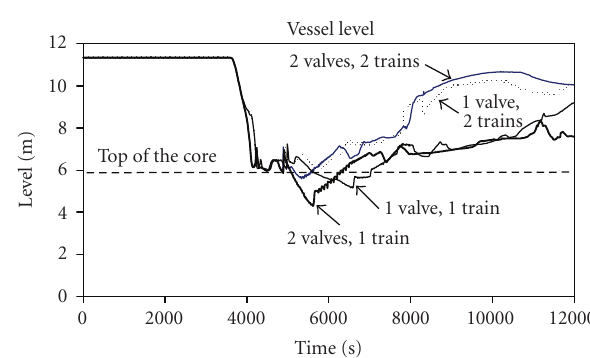
Figure 13: Reactor vessel level (F&B availability